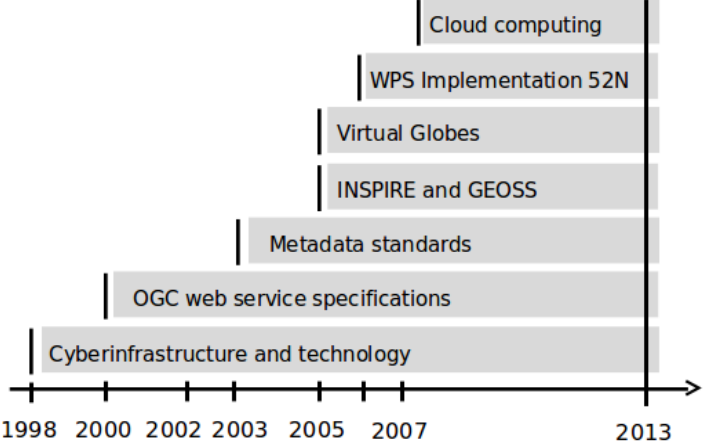
Figure 2. Time-line of developments related to e-Science in the geographic information